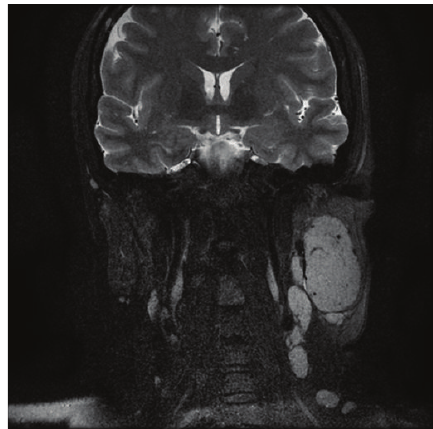
Figure 2: MRI head and neck coronal cut, after contrast, T2: a well- defined, T2 intermediate SI solid lesion in the left superficial parotid lobe. There is diffuse intense enhancement. Multiple enlarged lymph nodes in the left periparotid region.